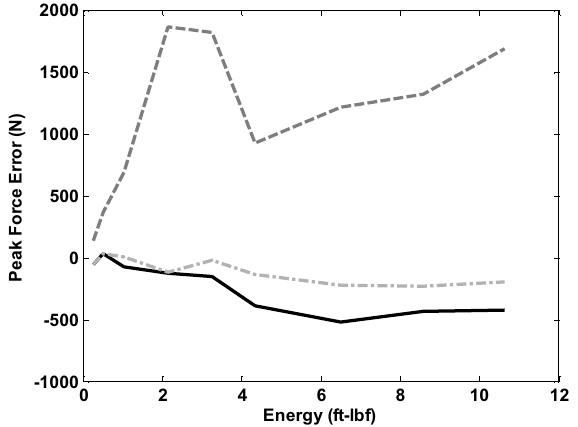
Fig. 29. Peak force error for the originally estimated force (——), the adjusted, curve-fit force without eliminating the foam effects (– – –), and the adjusted, curve-fit force after minimizing the effects of foam (– · – · ). technique is a global technique, i.e., it analyzes the shape of the force magnitudes over a broad range of frequencies. Conversely, the amplitude-basedtechnique finds the median force value for a frequencyregion consisting of multiple, narrow frequency spans. Both force-estimation techniques reduce an underdetermined system of equations into many overdetermined systems of equations in order to locate and quantify the applied